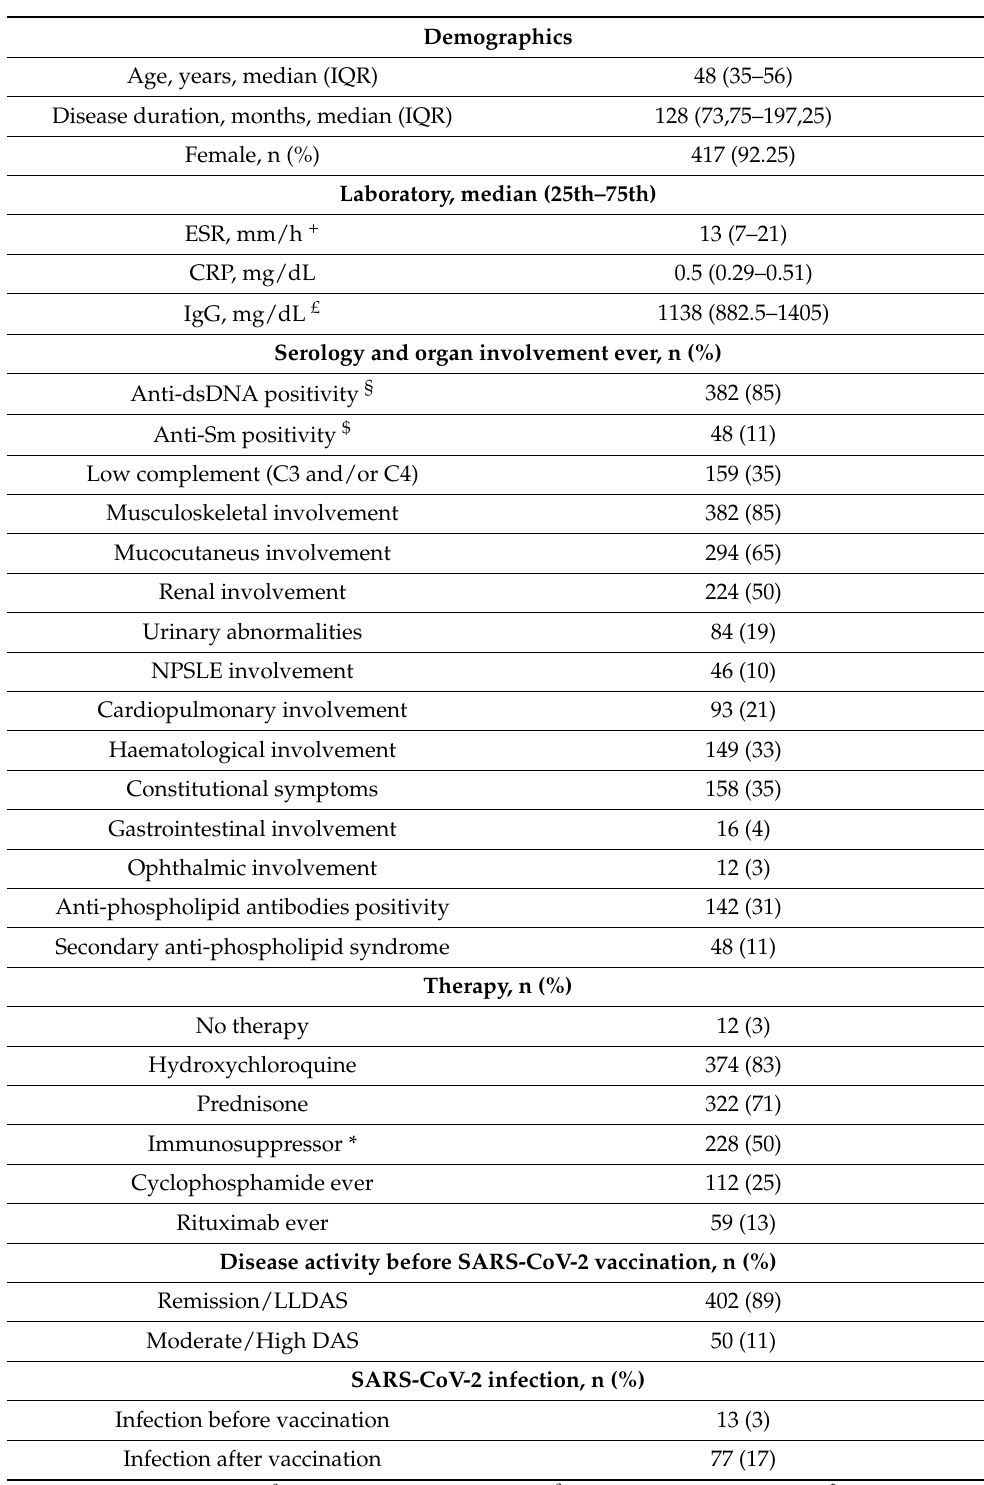
Table 1. Demographic, comorbidity, and SLE disease characteristics and therapies before SARS-CoV- 2